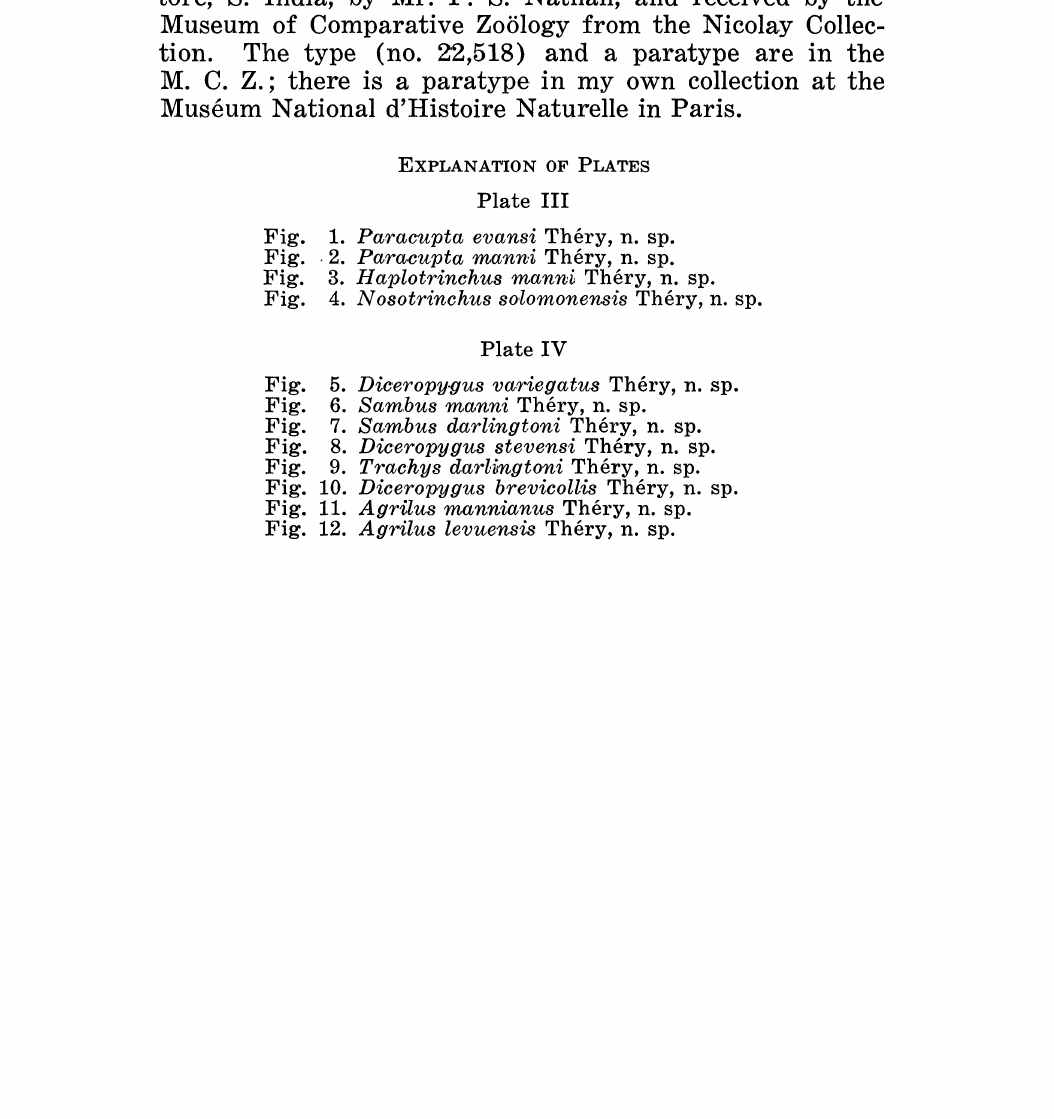
Fig. 1. Pa.racupta evansi Th6ry, n. sp. Fig. 2. Para.cupta manni Th6ry, n. sp. Fig. 3. Haplotrinchus man. Th6ry, n. sp. Fig. 4. Nosotrinchus so.Iomonensis Th6ry, n. sp.